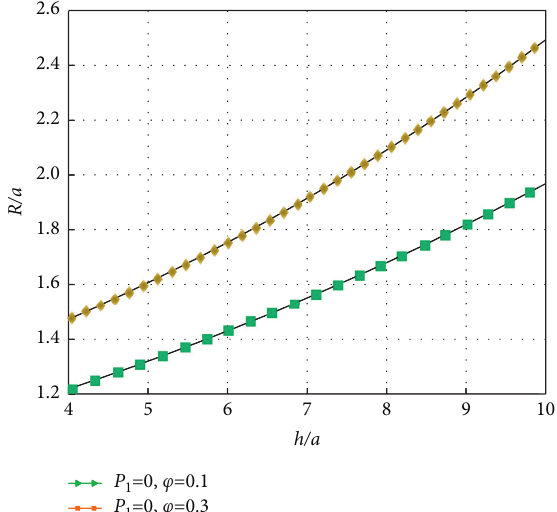
Figure 4: Relationship between R / a of plastic region and h / a under different water pressures and porosities. R / a is the size of the plastic expansion zone and h / a is the effective porosity water